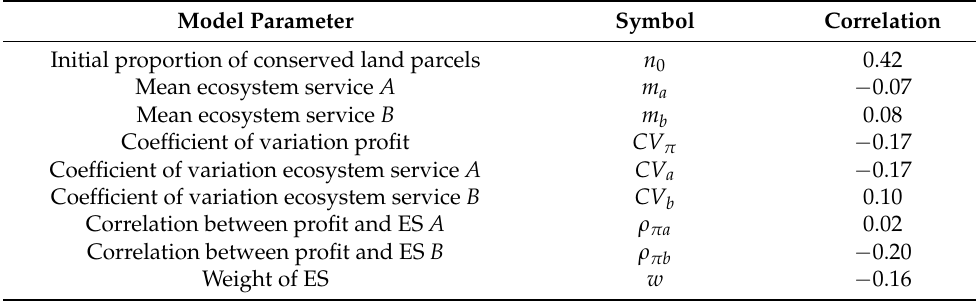
Table 3. Pearson correlation coefficients between model parameter and net loss ∆ A . Model